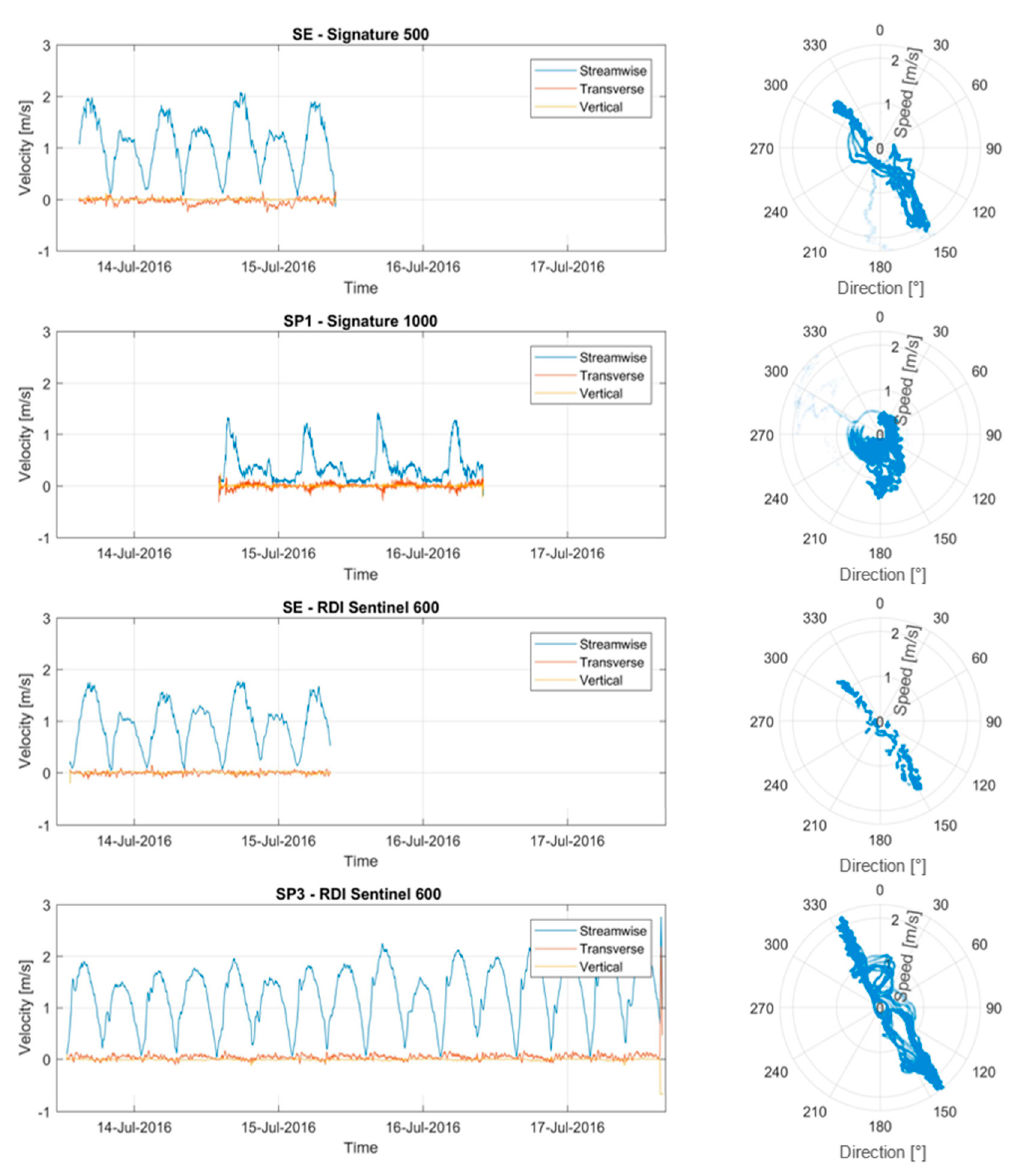
Figure 3. Left: Average flow velocity vectors over 10 min in the streamwise coordinate system for the SE—Signature 500, SP1—Signature 1000, SE—Sentinel V50 and the SP3—Workhorse. Right: Average flow direction (degrees) and velocity (m/s) for the same sensors at a 10 min interval. With the start date time of the 13 July 2016 11:00:00 am. All data provided is taken 10 m above the seabed.